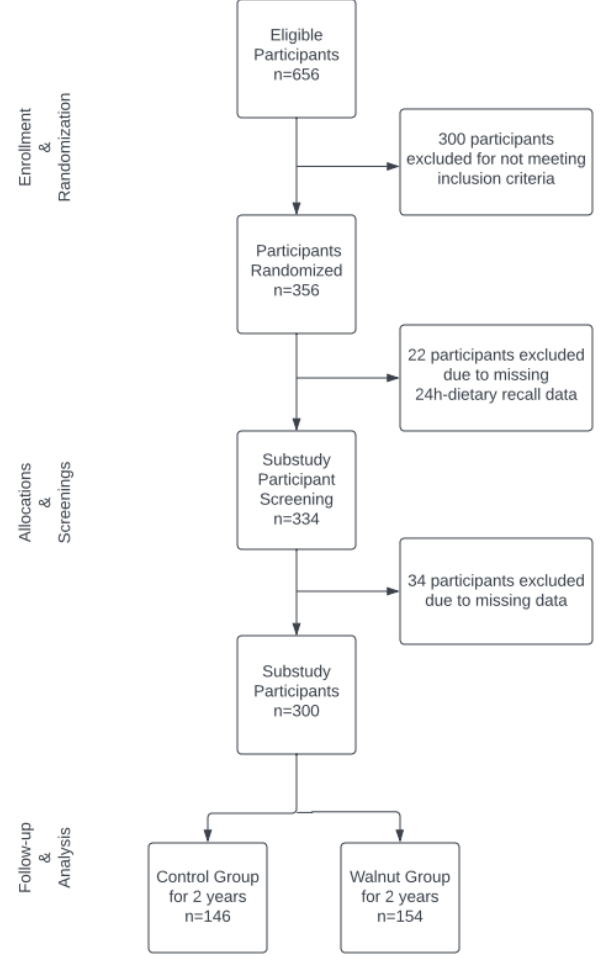
Figure 1. Participant flowchart at LLU site.